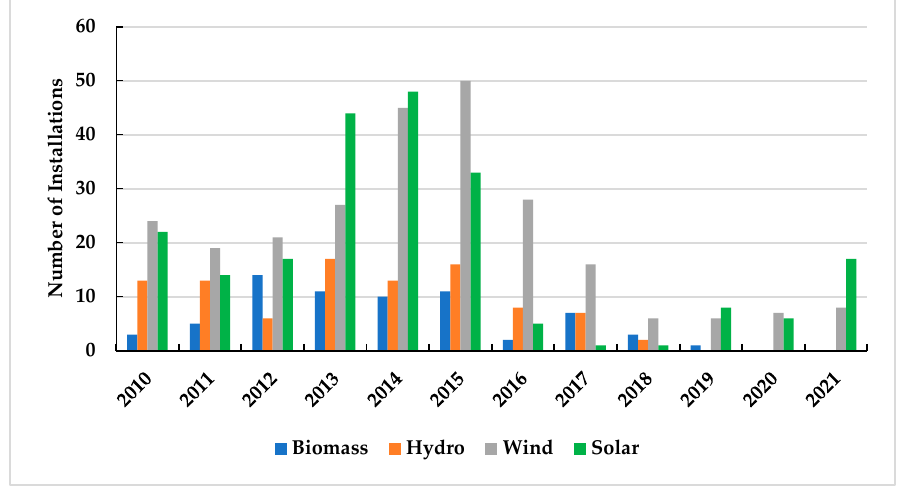
Figure 3. Installed and in-operation renewable energy projects between 2010 and 2021 [31,33,88].